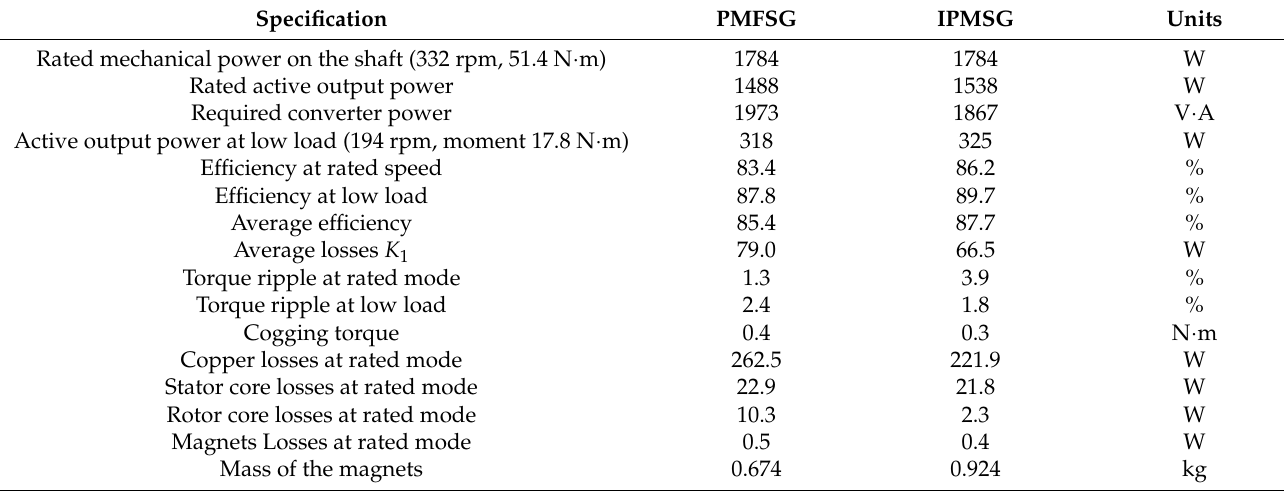
Table 10. Characteristics of the optimized PMFSG and